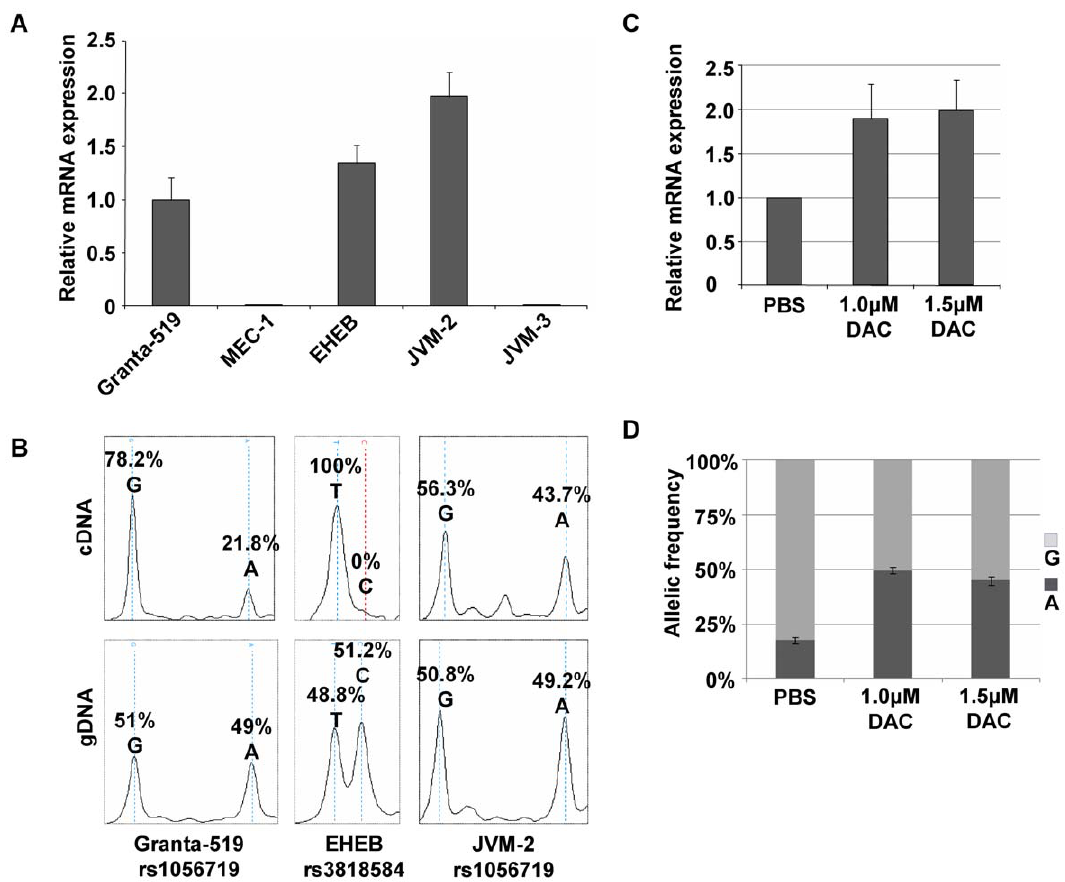
Figure 3. Allele-specific expression (ASE) of DAPK1 is prevalent in B-cell malignancy derived cell lines. (A) TaqMan real-time PCR of cDNA from five B-cell malignancy cell lines (Granta-519, MCL; MEC-1, B-PLL; EHEB, chronic B-cell leukemia, JVM-2, B-PLL; JVM-3, B-PLL) show relative expression levels of DAPK1 mRNA expression normalized to three house-keeping genes. (B) Allelic ratios of cDNA and gDNA are quantified by SNuPE/ MALDI-TOF. Representative spectra demonstrate an imbalanced allelic mRNA expression compared to allelically balanced gDNA. Molecular weight range 5390–5500 Da is displayed for rs1056719 (G/A) in Granta-519 and JVM-2 cells and 6985–7045 Da for rs3818584 (T/C) in EHEB. Peak height/ signal intensity correlates with allele abundance. (C) qPCR-based DAPK1 mRNA quantification upon treatment with the DNMT inhibitor (5-aza-2 9 - deoxycytidine, DAC) in Granta-519. The values are relative to the respective mock control (PBS). (D) Allelic ratios of SNP rs1056719 in Granta-519 cells measured by SNuPE/MALDI-TOF assay upon DAC